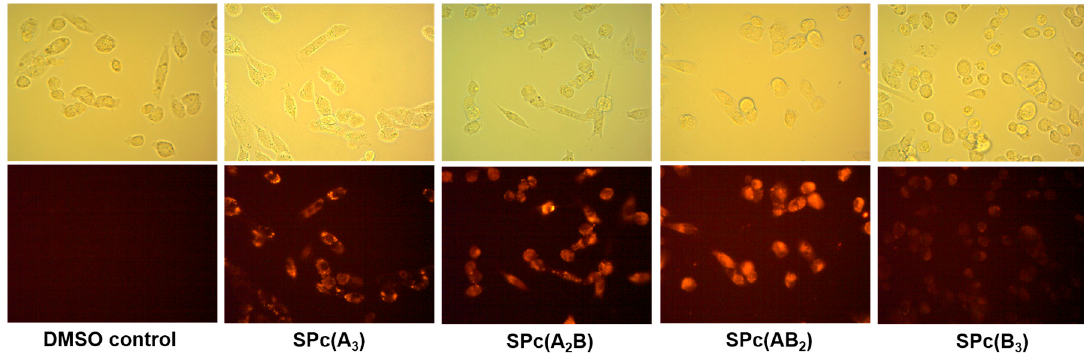
Figure 3. Brightfield ( upper ) and epifluorescence (( lower ) λ ex = BP 528–553 nm, λ em = BP 578–633 nm) of MDA-MB-231 breast tumor cells treated with 50 µM SPc for 15 min (400×).